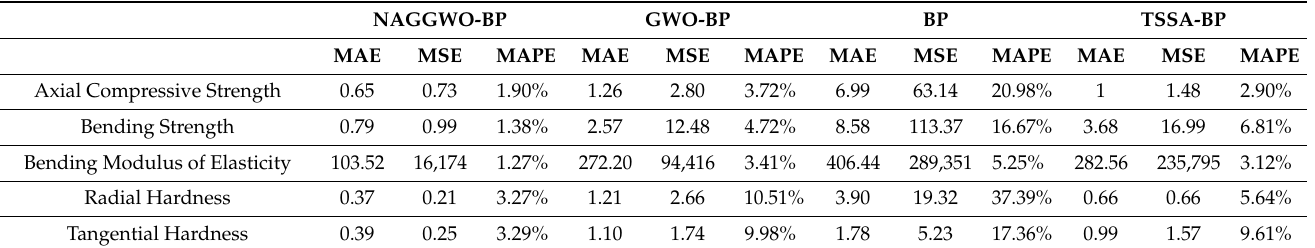
Table 2. Model and error